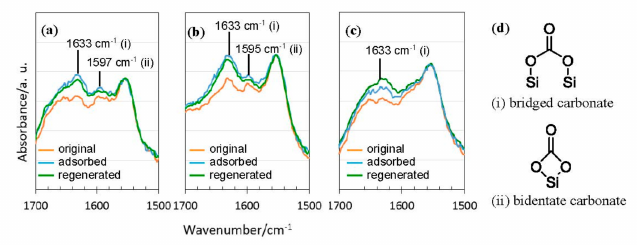
Figure 14. CO 2 capture capacity vs. SSA of ROSZ-derived amorphous Si–O–N